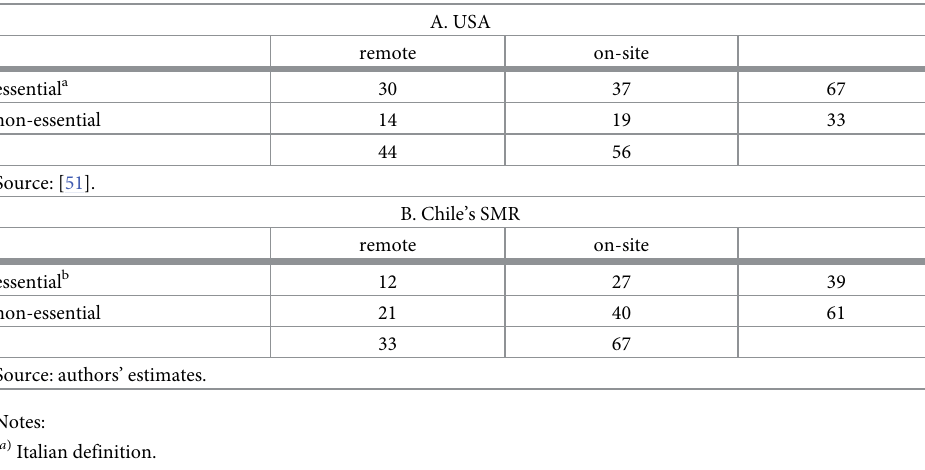
Table 2. Different estimates of teleworking ability and